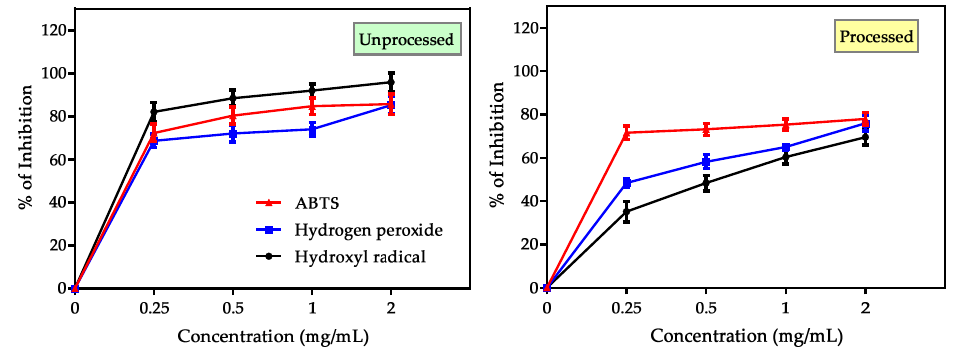
Figure 6. HAT based assay of Mandelup seed flours in unprocessed and processed conditions. Antioxidant potential of unprocessed and processed flours of most active cultivar: Mandelup assayed by HAT based (hydrogen peroxide, hydroxyl radical and ABTS radical scavenging) methods; each experiment was performed three times and data were expressed as mean ± SEM.